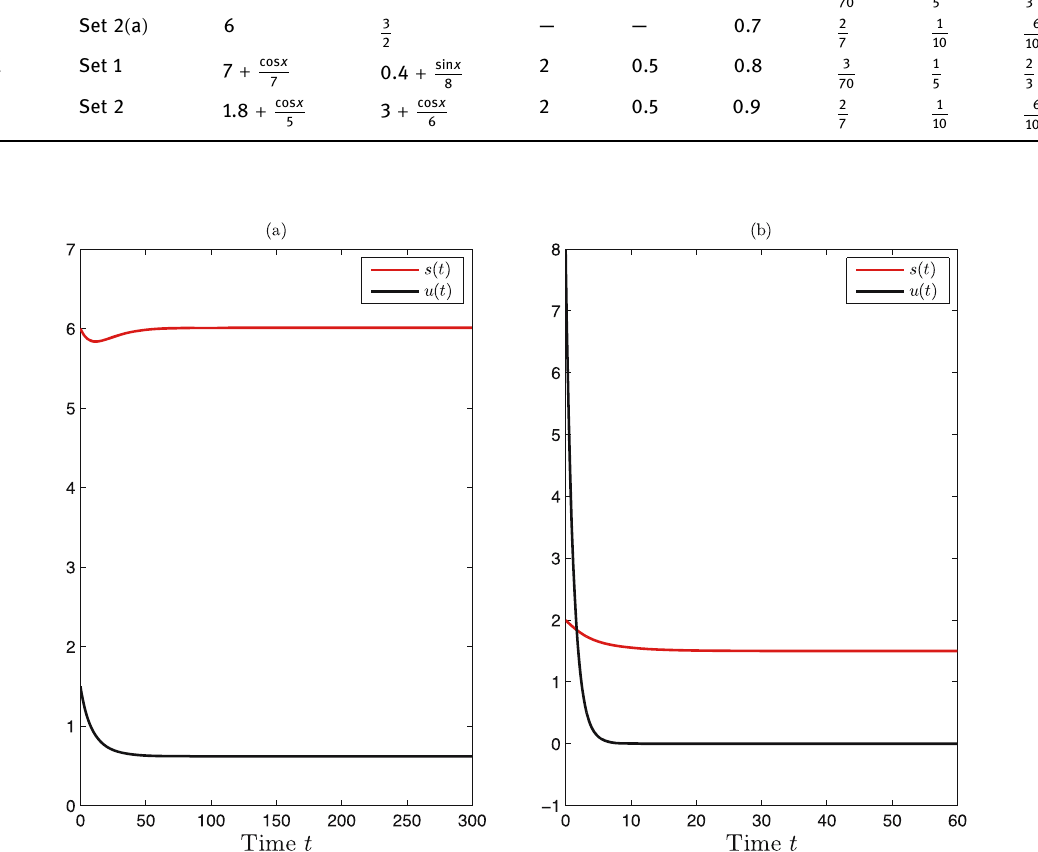
Figure 4: Numerical solutions of system ( 61 ) ( ODE case ) subject to the fi rst and second sets of